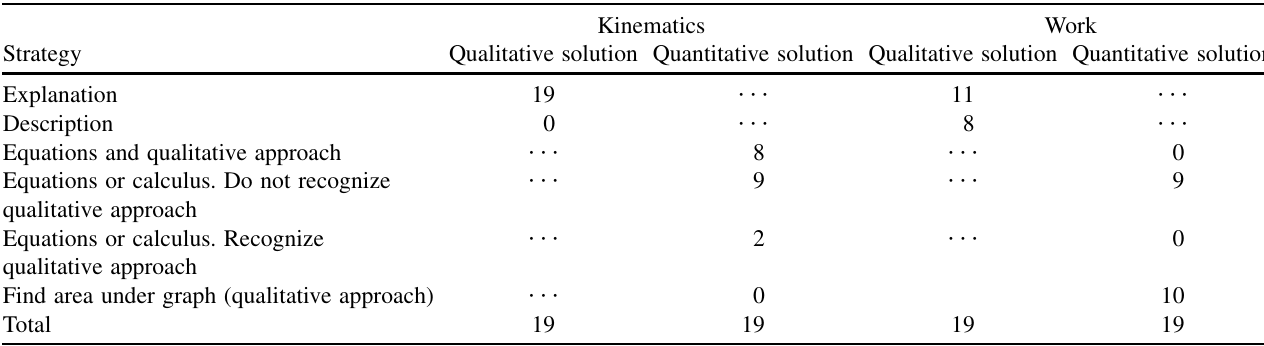
TABLE VIII. Comparison of strategies when handling tasks, from kinematics and work, posed in graphical form.